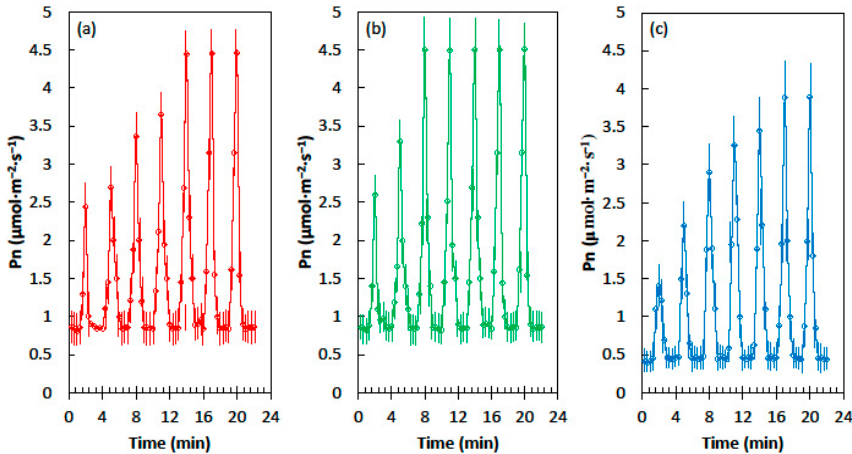
Figure 1. Net CO 2 assimilation (Pn) of the Cycas micronesica leaves in response to the alternating shade flecks with a photosynthetic photon flux density (PPFD) of 55 µmol·m − 2 ·s -1 and the light flecks with a PPFD of 800 µmol·m − 2 ·s -1 . The experimental leaves were grown in ( a ) homogeneous 62% sunlight exclusion under a shade screen, ( b ) heterogeneous 62% sunlight exclusion under a slat-house, or ( c ) full sun. Each marker is a mean of four replications.